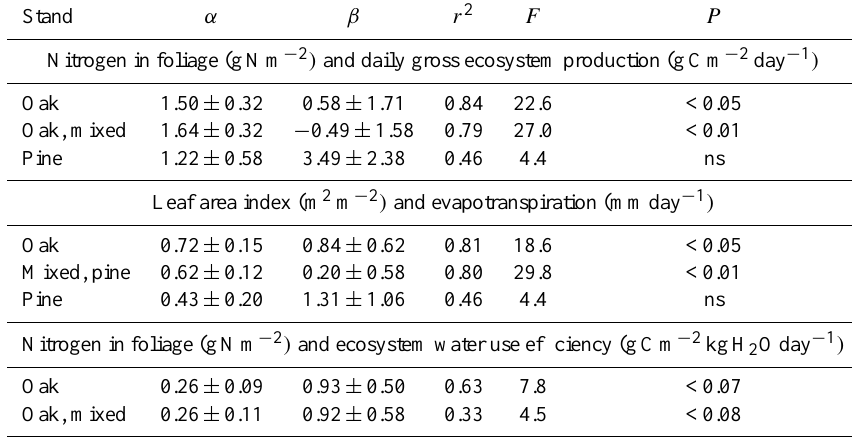
Table 5. Parameters and statistics for the relationship between maximum canopy and understory N content and mean daily gross ecosystem productivity, and between maximum LAI and mean daily Et during the summer from 1 June to 31 August. Data were fitted to GEP = α (canopy N) + β . Parameter values are means ± 1 standard error, r 2 is the value of the Pearson’s product moment coefficient, F is the value of the F statistic, and P is the significance level of the ANOVA analyses for each model. Values are for the oak stand from 2005 to 2009, the mixed stand from 2005 to 2007, and the pine stand from 2005 to